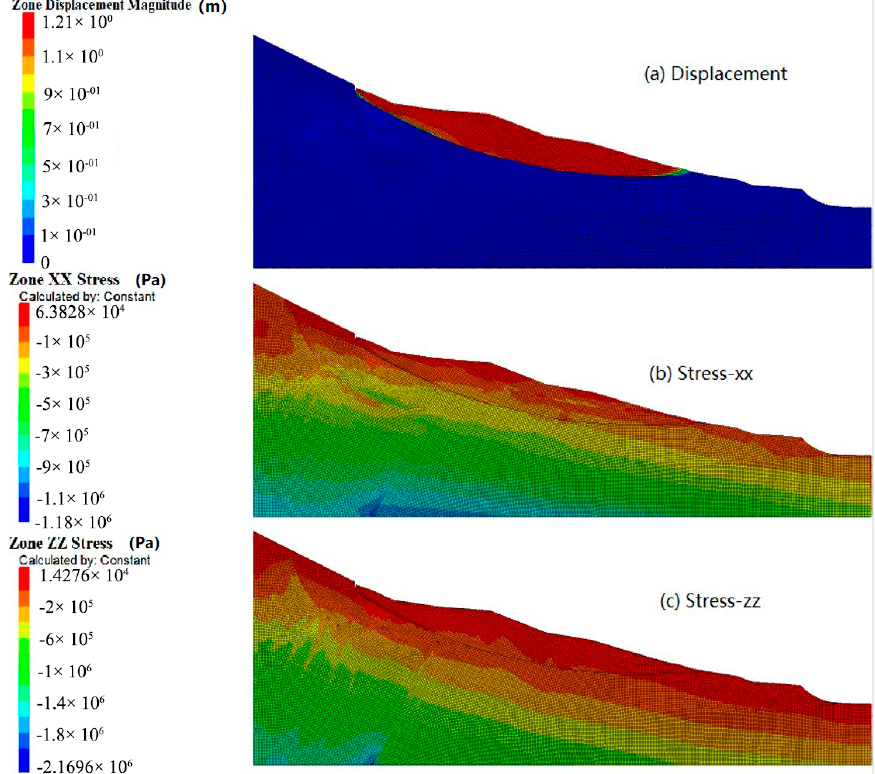
Figure 22. Calculated results of numerical model.